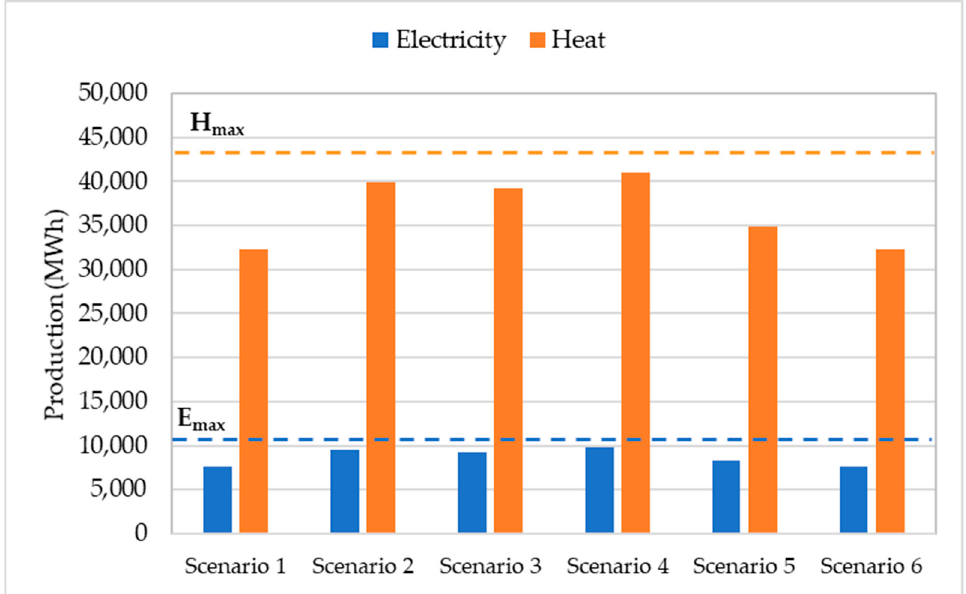
Figure 8. The minimum production of heat and electricity required to be